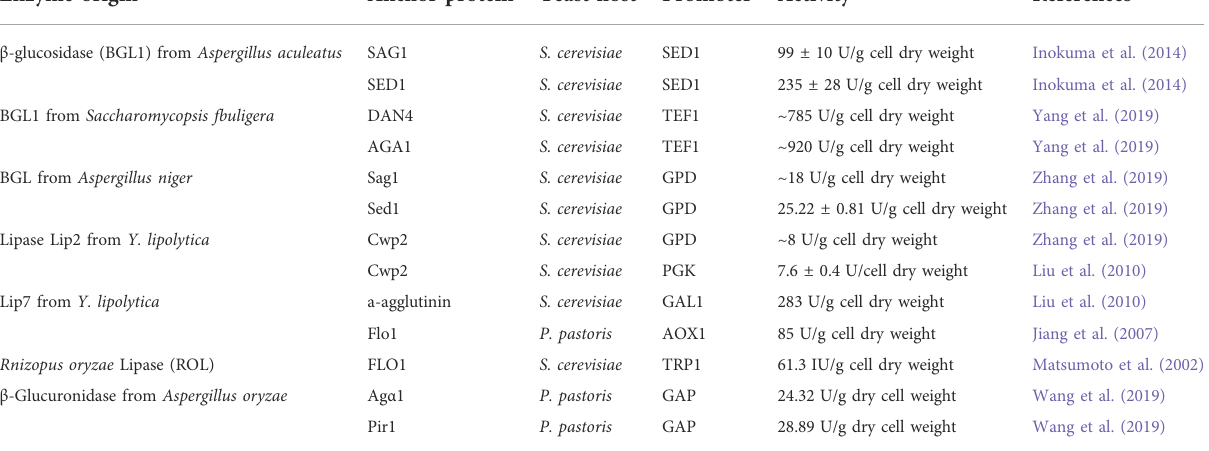
TABLE 2 Comparison of anchoring ef fi ciencies of different anchor proteins. Enzyme